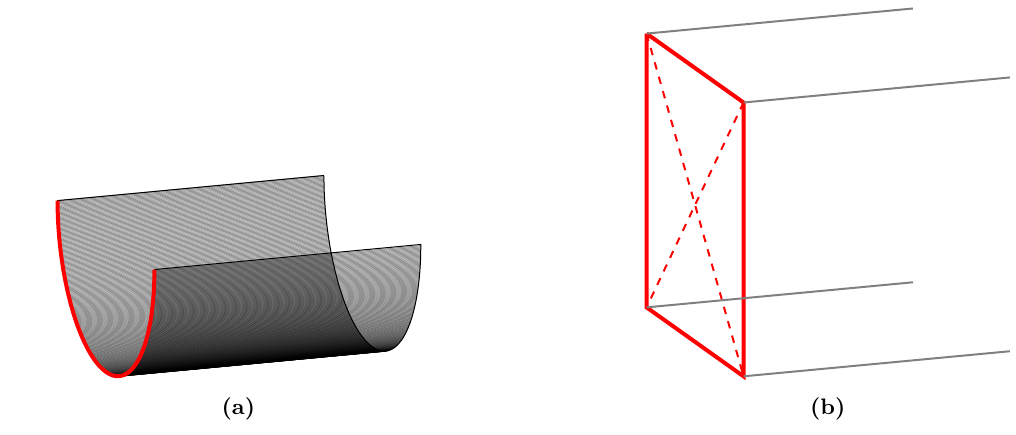
Figure 6. (a) The two-BCFT state in figure 5 approximating the vacuum of a single CFT can be understood as a thermofield double state of two BCFTs. (b) The dual geometry is a portion of the planar two-sided black hole capped off by an ETW